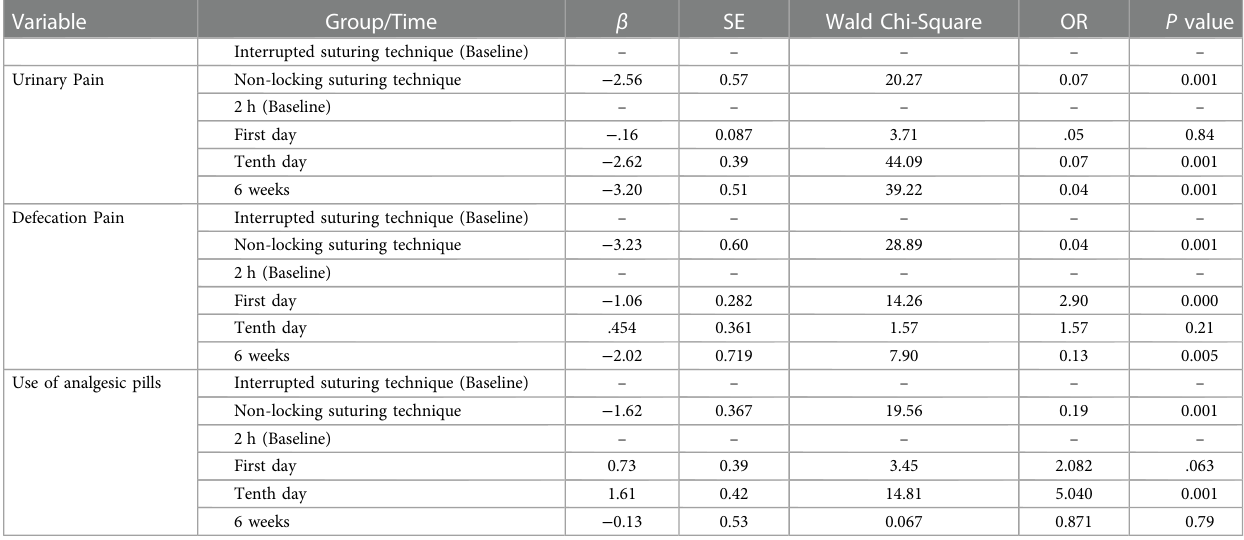
TABLE 4 Results of generalized estimating equations model in examining the trend of changes in secondary outcomes in terms of group and time.